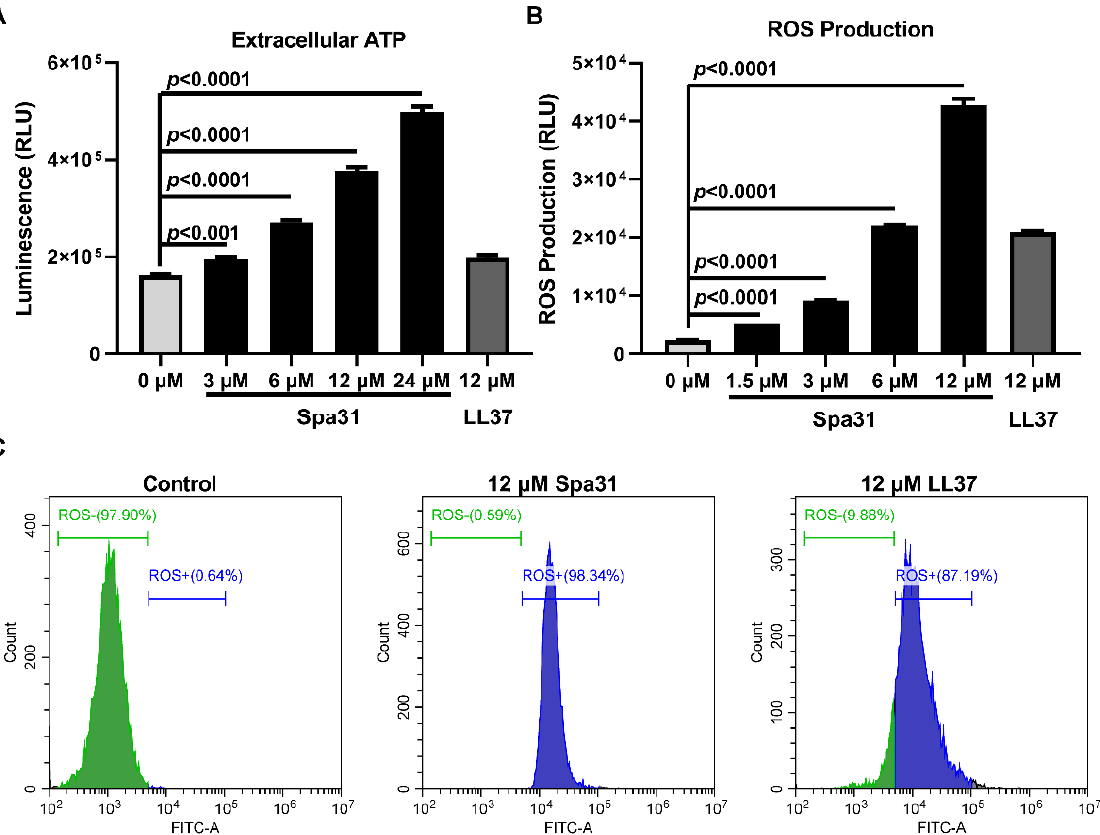
Figure 6. Effects of Spa31 on ATP release and ROS production in P. aeruginosa . ( A ) Detection of extracellular ATP in P. aeruginosa after Spa31 treatment. ( B ) The fluorescence intensities of DCFH-DA in P. aeruginosa after Spa31 treatment was analyzed by microplate reader ( B ) and flow cytometry ( C ). LL-37 treatment group was used as a control.